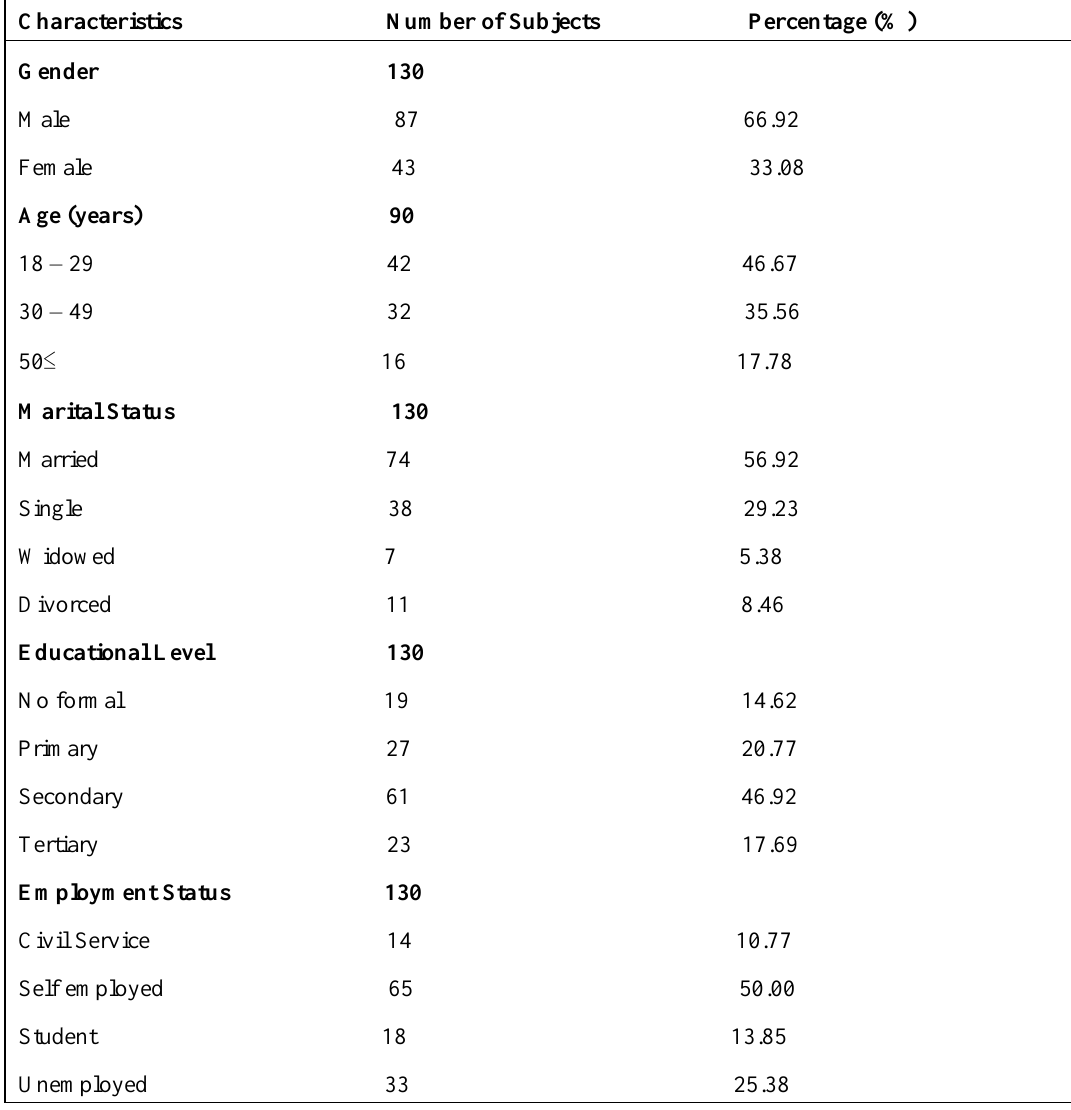
Table 1. Socio demographic MDR-TB/HIV co-infected group.